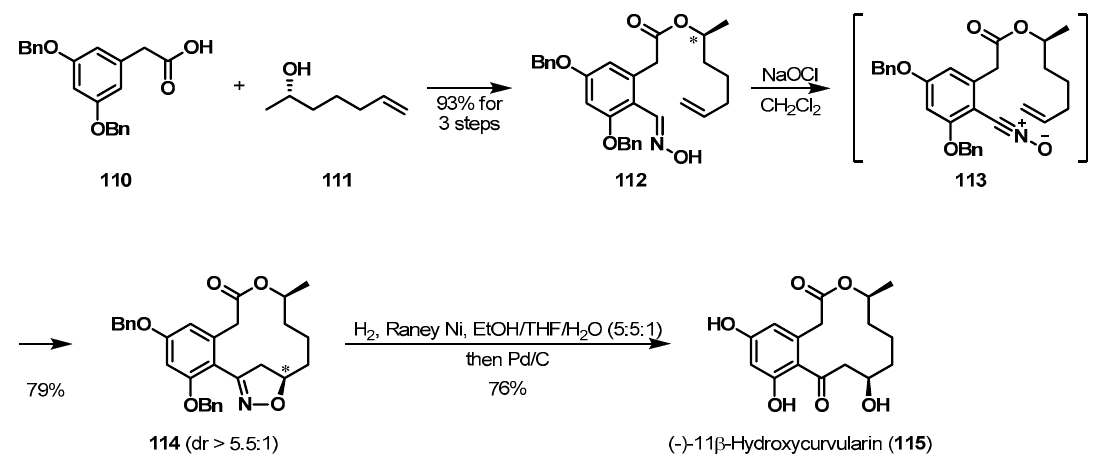
Scheme 17. Total synthesis of (–)-11 β -hydroxycurvularin ( 115 ).